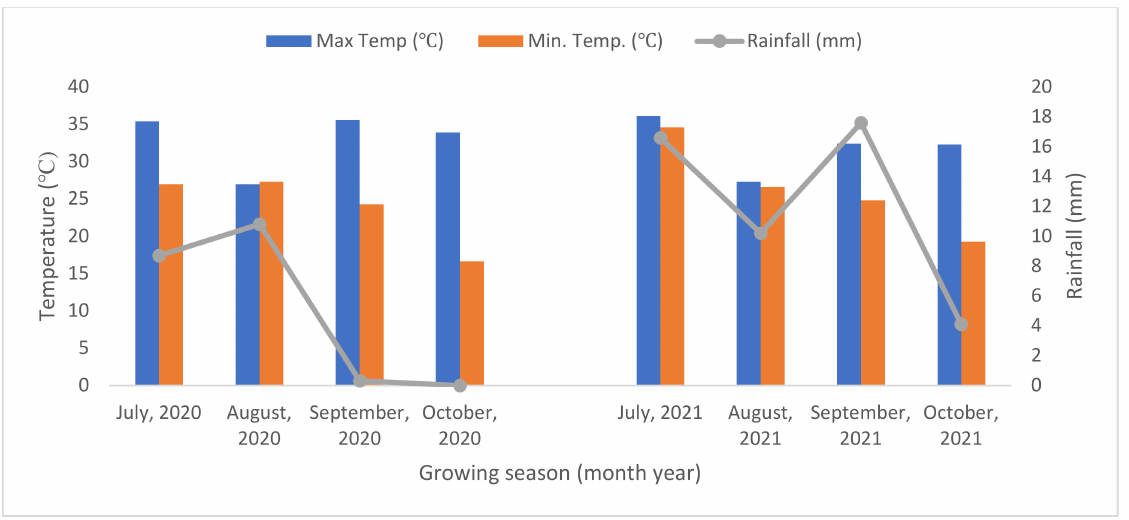
Figure 3. Mean monthly temperatures and rainfall received during pearl millet growing season at Research Farm IARI field trial site.